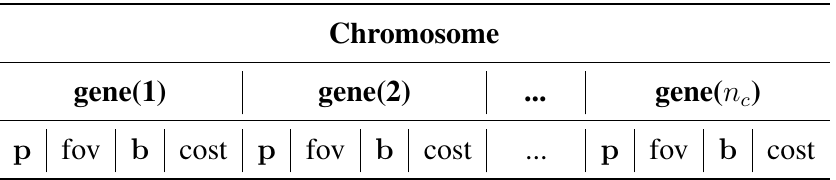
Table 1. Structure of a chromosome